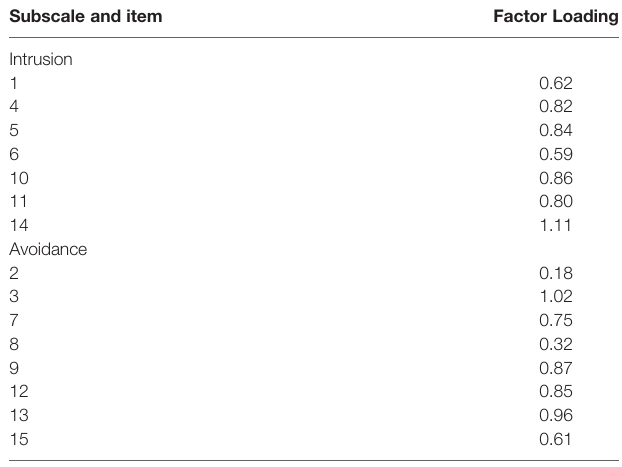
TABLE 3 | Factor Loadings in Model